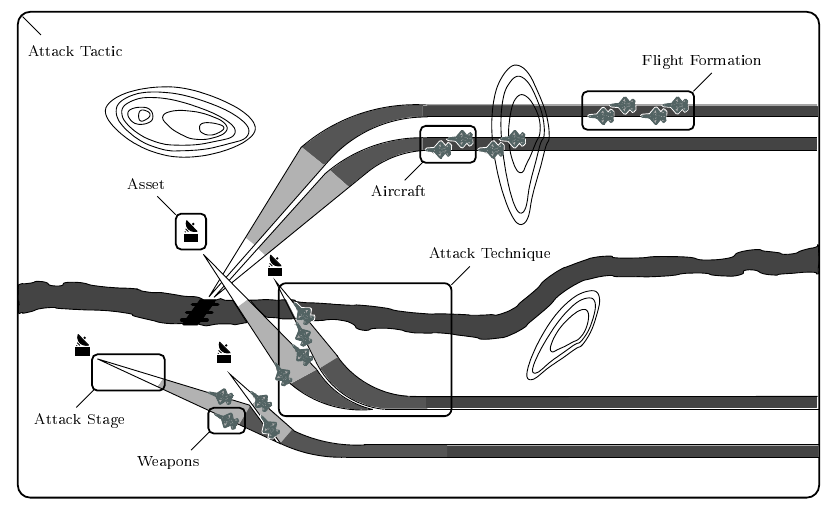
Figure 1: The various formative elements of a tactical situation (as seen from